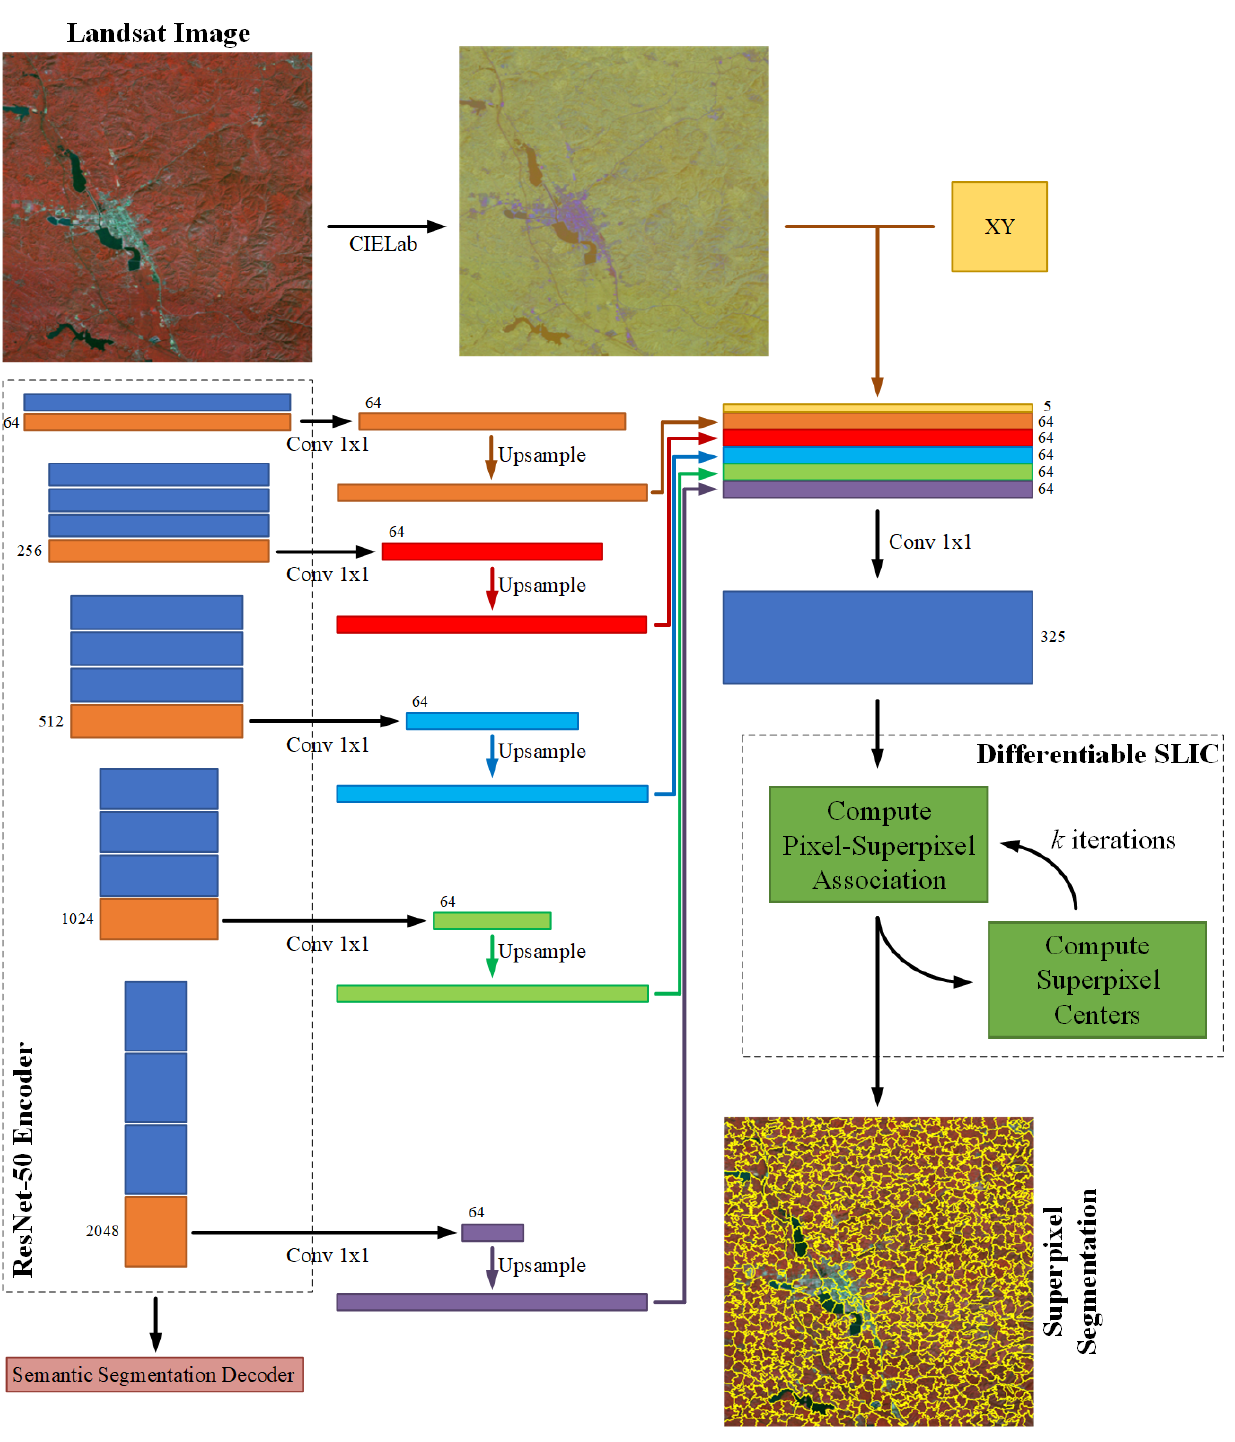
Figure 6. Details of the superpixel